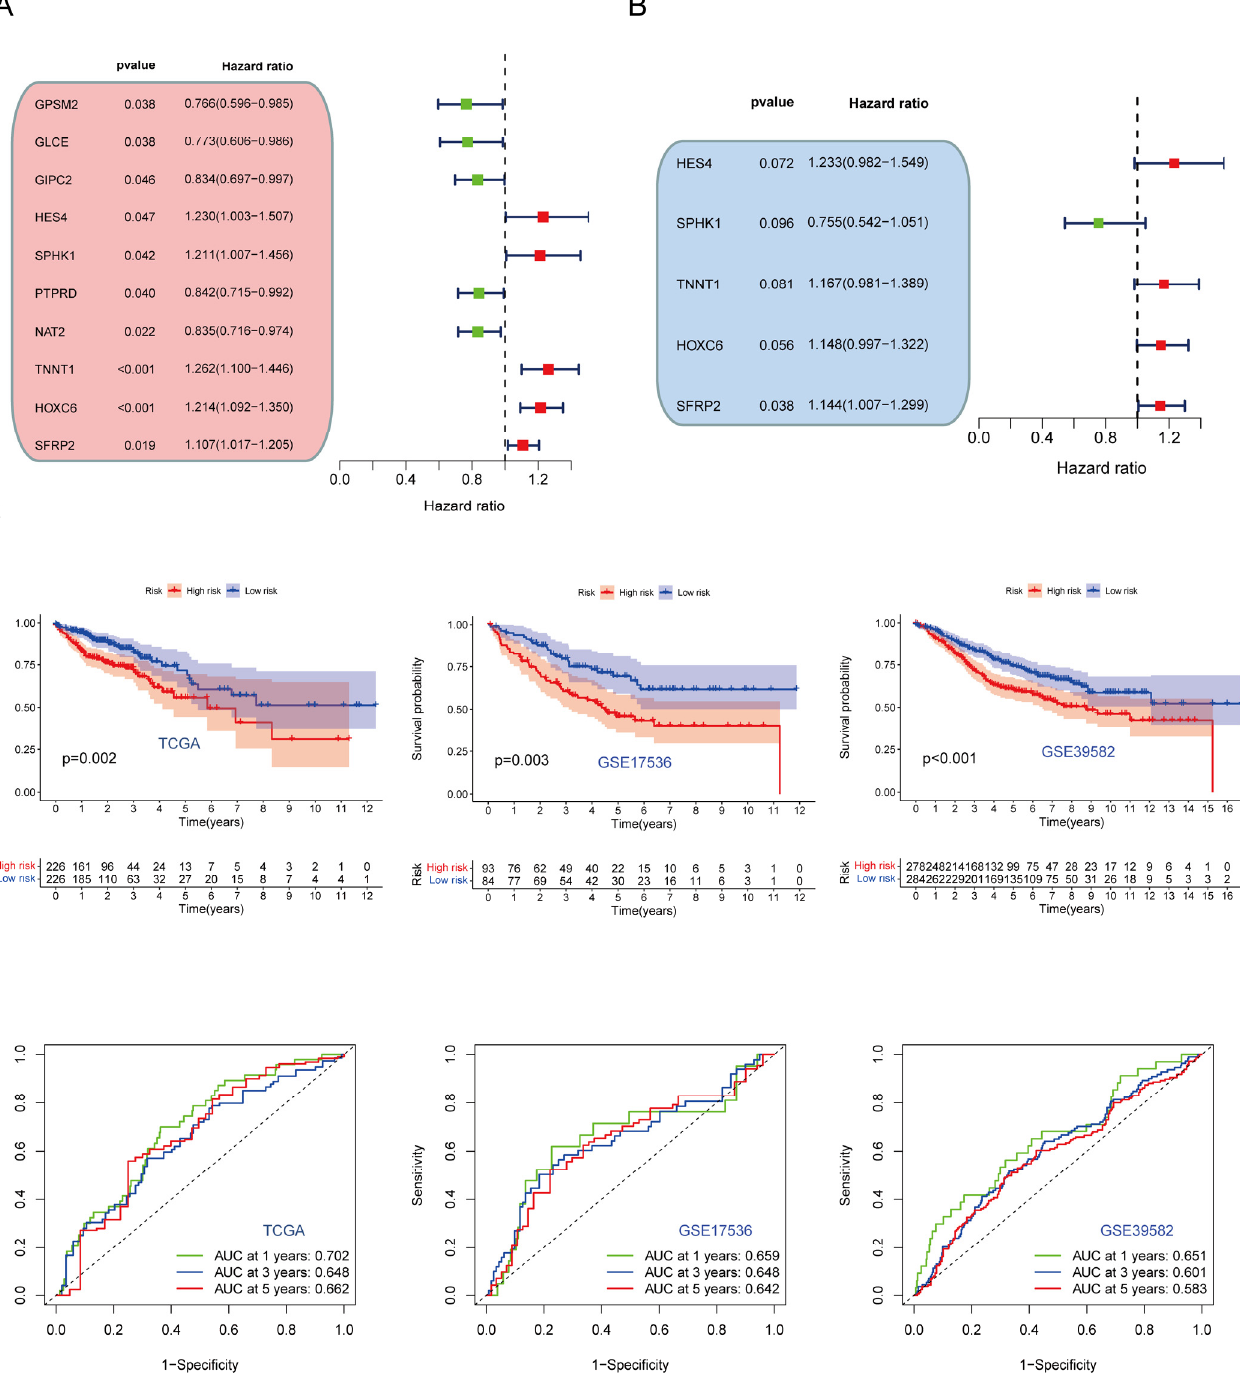
Figure 4. Construction and validation of the prognostic signature. ( A ) Univariate and ( B ) multivariate Cox regression analysis identifies prognosis-related genes. ( C ) Kaplan–Meier survival curves for patients in the high and low CPS-score groups in the training and test sets. ( D ) Receiver operating characteristic curves for 1-, 3-, and 5-year survival in the training and validation sets.